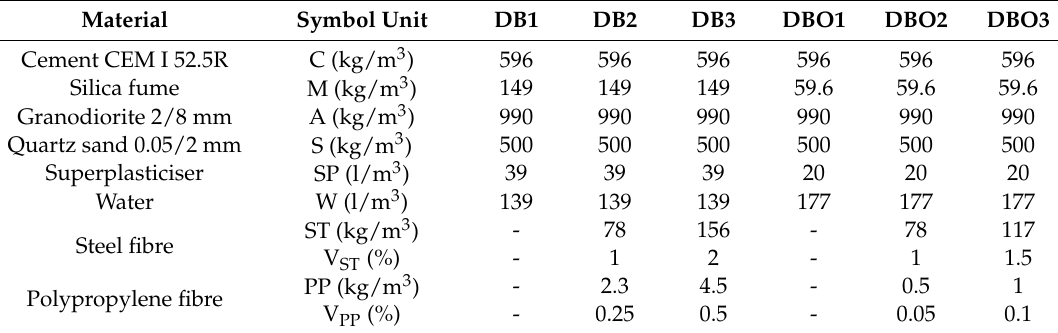
Figure 3. Fibres used in this study ( a ) steel fibres; ( b ) polypropylene fibres.